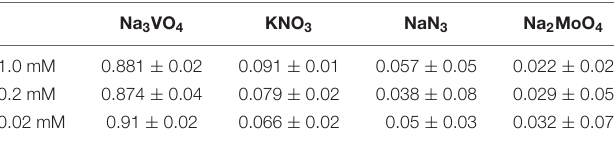
TABLE 1 | The purity of plasma membrane isolated from tomato roots was analyzed by the activity of various inhibitor-sensitive ATPases in the membrane fraction.